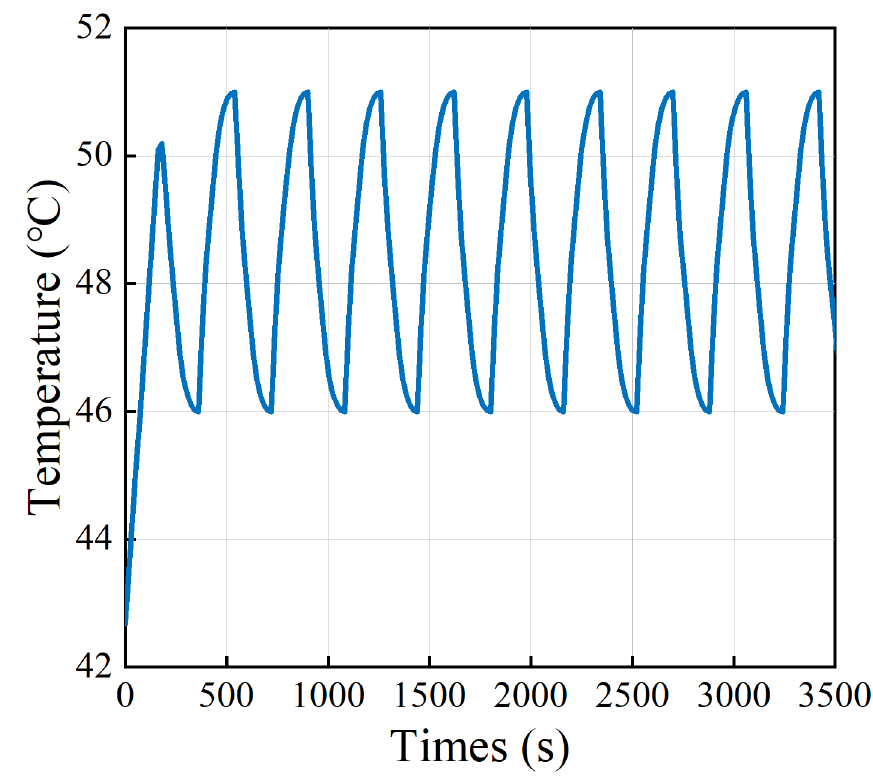
Figure 15. Motor stator